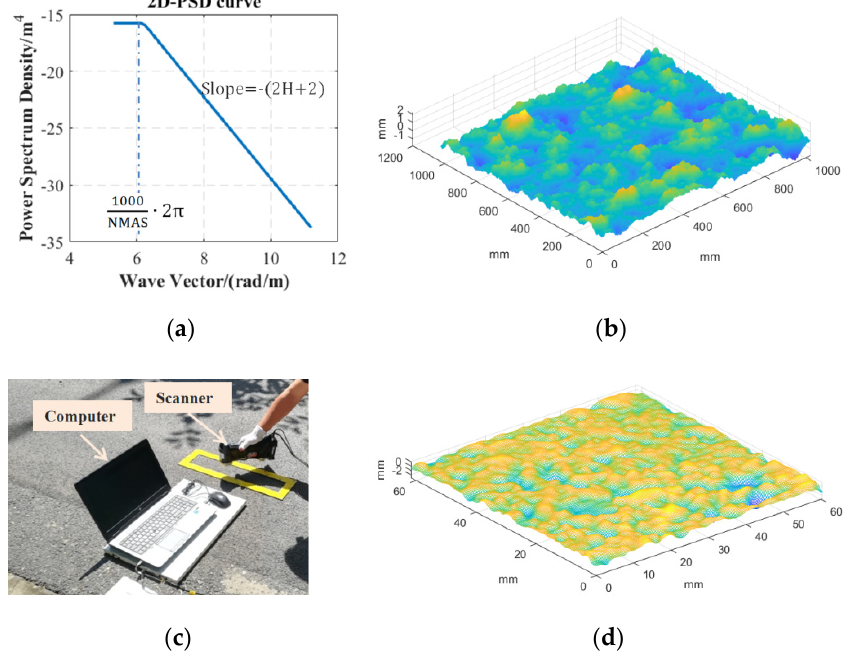
Figure 2. ( a ) PSD curve used for generating ( b ) an artificial surface, and ( c ) reconstructed AC pavement surface captured by ( d ) the 3D scanner.